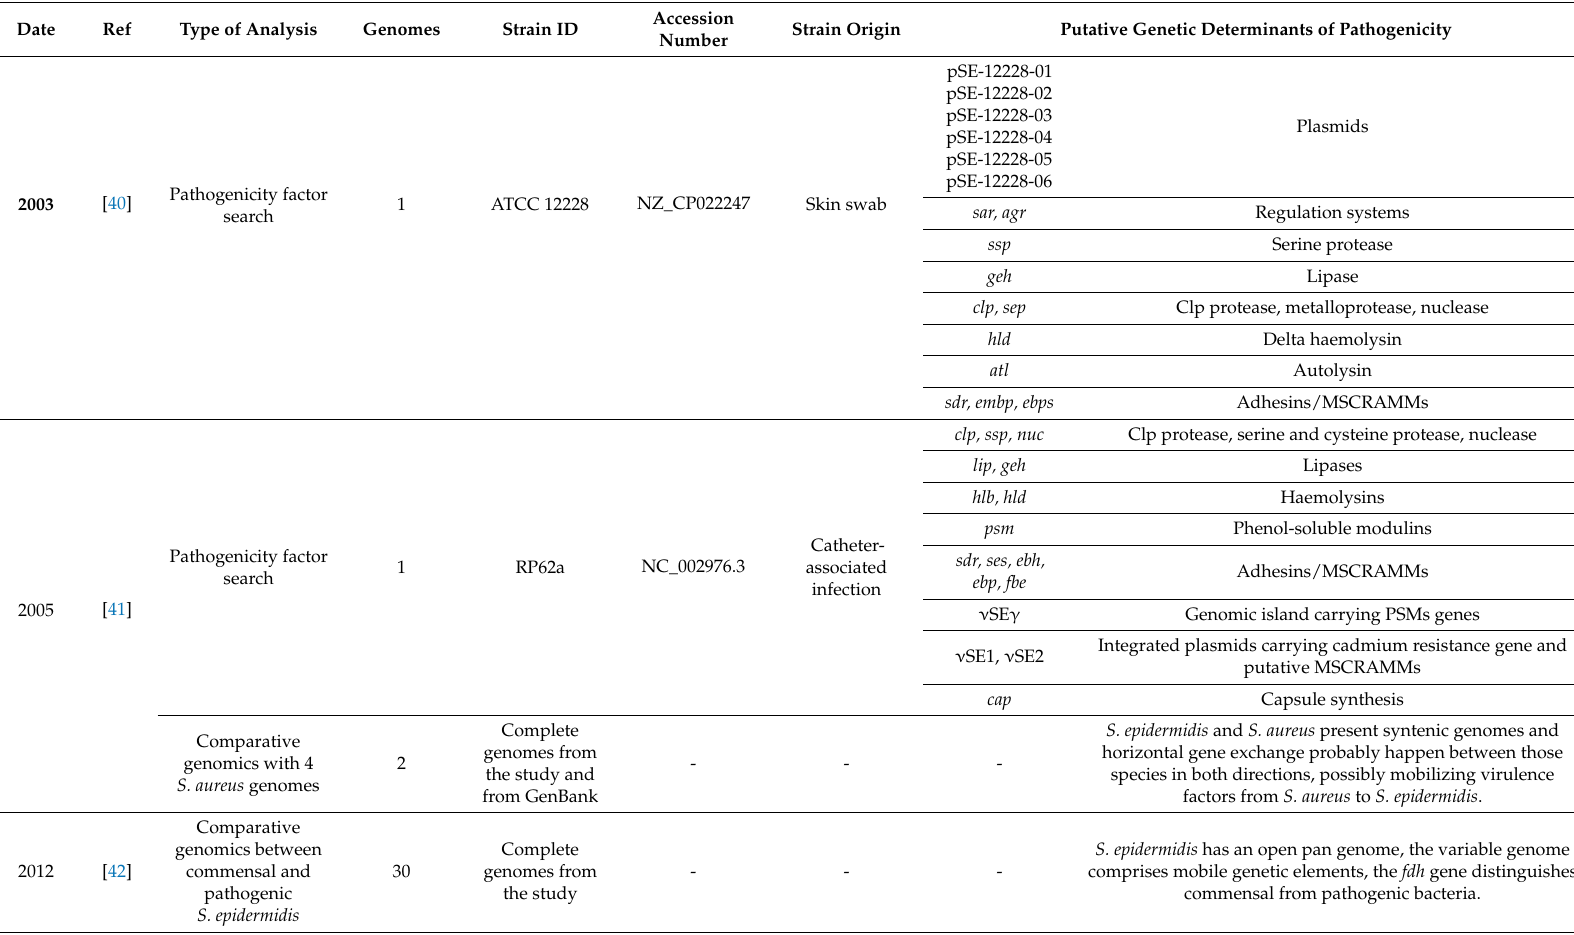
Table 1. Staphylococcus epidermidis whole-genome-based studies to determine virulence